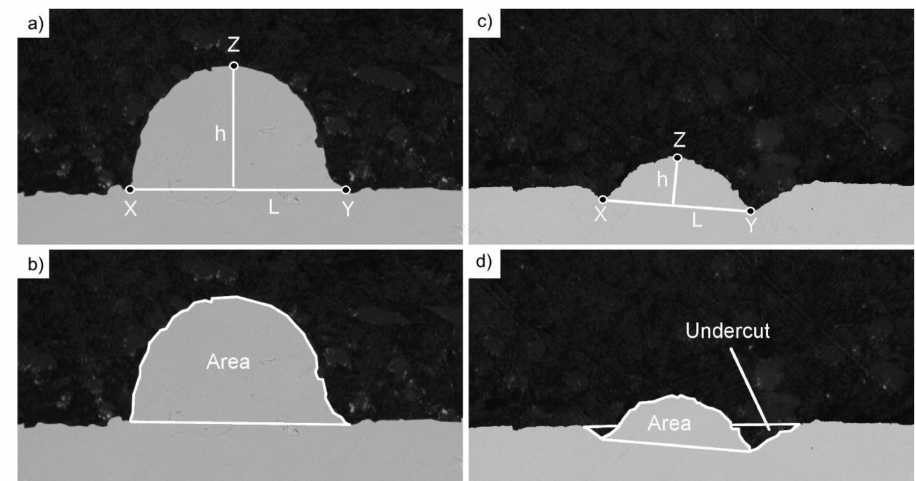
Figure 4. Measurement scheme of a single-track cross-section (STCS): ( a ) base length and height of a proper track; ( b ) area and perimeter of a proper track; ( c ) base length and height of a depleted track; ( d ) area and Undercut of a depleted track.